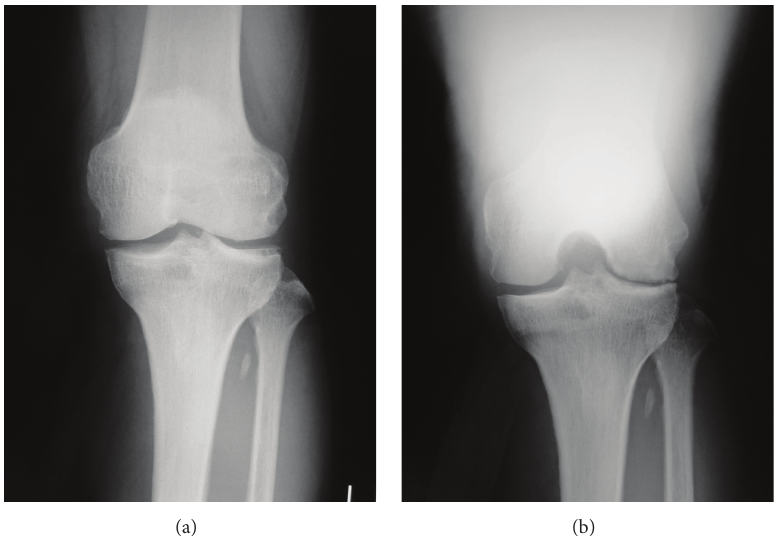
Figure 1: Radiographs of Case 1 . AP view (a) shows grade 3 osteoarthritis according to Kellgren and Lawrence scale and Rosenberg view (b) shows lateral-dominant osteoarthritis.